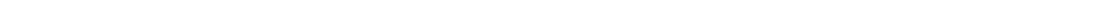
Fig. 5 H4K20me3 contributes to DNA damage repair and genome maintenance. a – d MEFs cultured under the indicated conditions and treated with or without inhibitors were collected for immuno fl uorescent staining of γ H2AX ( a , b ) or 53BP1 ( c , d ). Scale bar, 5 μ m. e Etoposide-treated control (shCtrl) or Suv4-20h2 knockdown (shSuv4-20h2) cells were subjected to γ H2AX staining according to the indicated time course. Scale bar, 5 μ m. f – j Nuclei from cells grown in 3% oxygen or 20% oxygen and treated with or without E-616452, were incubated with 0, 0.5 or 2 U of MNase for 5 min followed by DNA extraction, agarose gel electrophoresis and ethidium bromide staining. The asterisks indicate prominent fragment changes ( f ). The band densities were quanti fi ed using Image J software and illustrated as percentage of the signal subtracted background of the entire line from top to the bottom. Calibrated kilobase pair (kbp) sizes are indicated ( g – j ). k Wild-type HEK293T (293T WT) and SUV4-20H knockout cells ( SUV4-20H KO #1 and SUV4-20H KO #2) were treated with the indicated concentration of etoposide, followed by crystal violet staining. Scale bar, 100